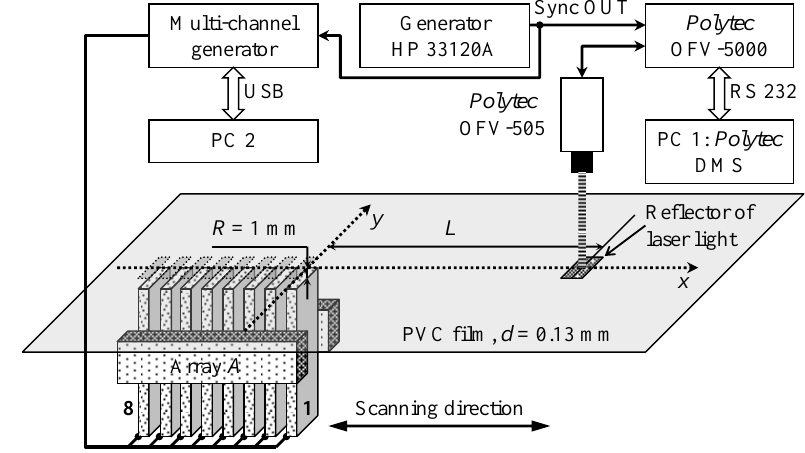
Figure 25. Experimental set-up used for air-coupled excitation of a slow A 0 Lamb wave.